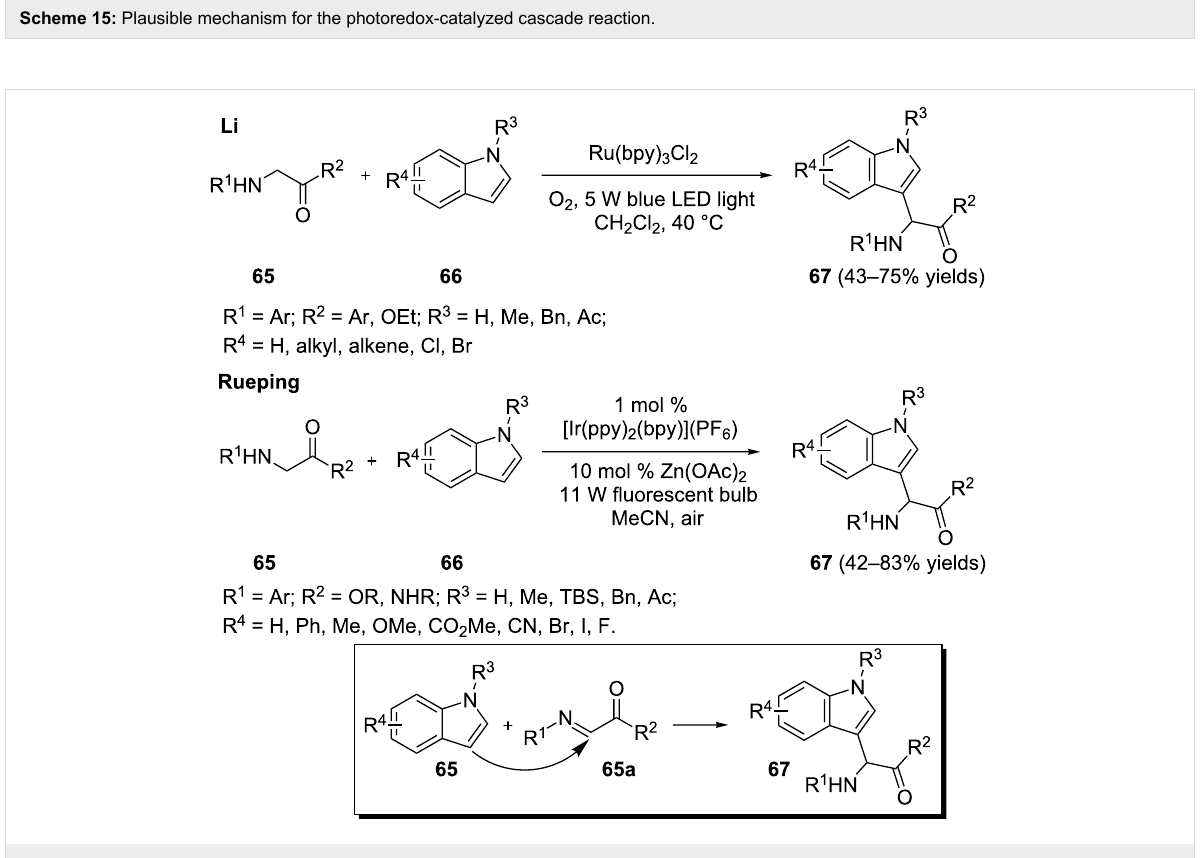
Scheme 15: Plausible mechanism for the photoredox-catalyzed cascade reaction.